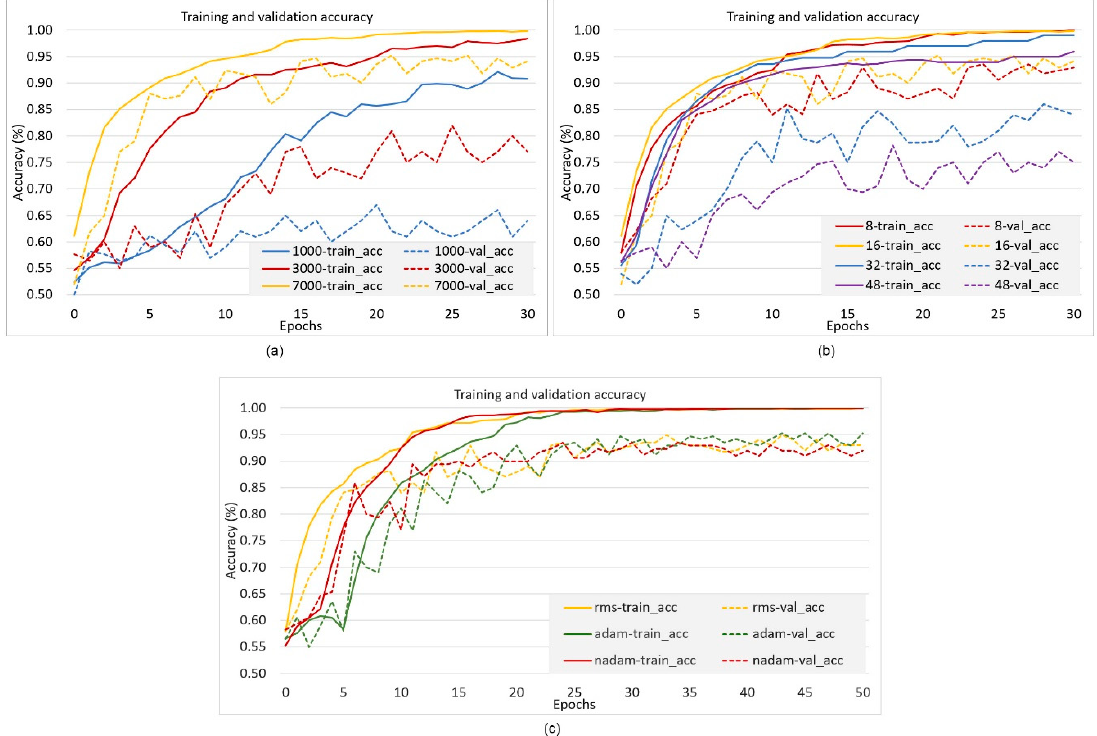
Figure 6. Traces of training and validation accuracy during custom CNN training with ( a ) different training dataset size, ( b ) different batch size and ( c ) different optimizers.